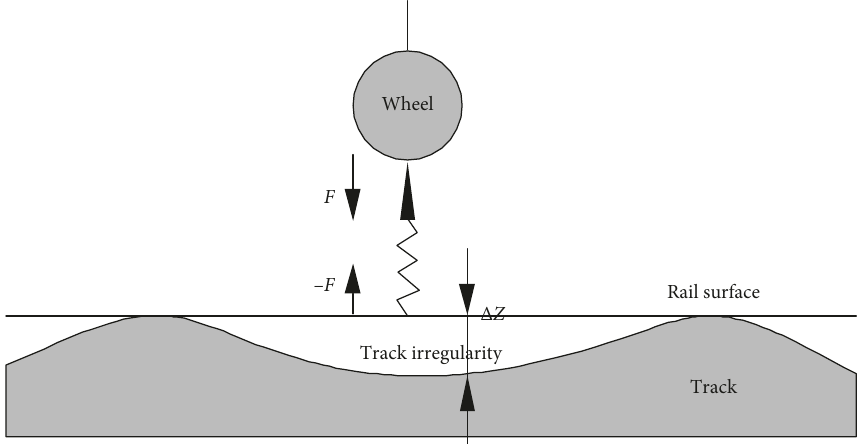
Figure 1: Wheel-rail contact illustration.